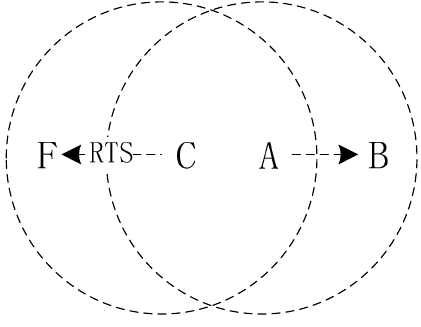
Figure 2. An example of exposed terminals.